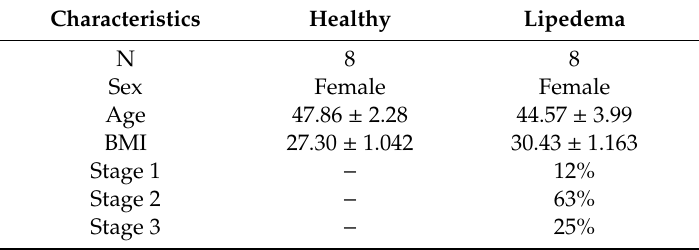
Table 1. Characteristics of healthy and lipedema patients. Lipedema stages are explained in detail in [30].